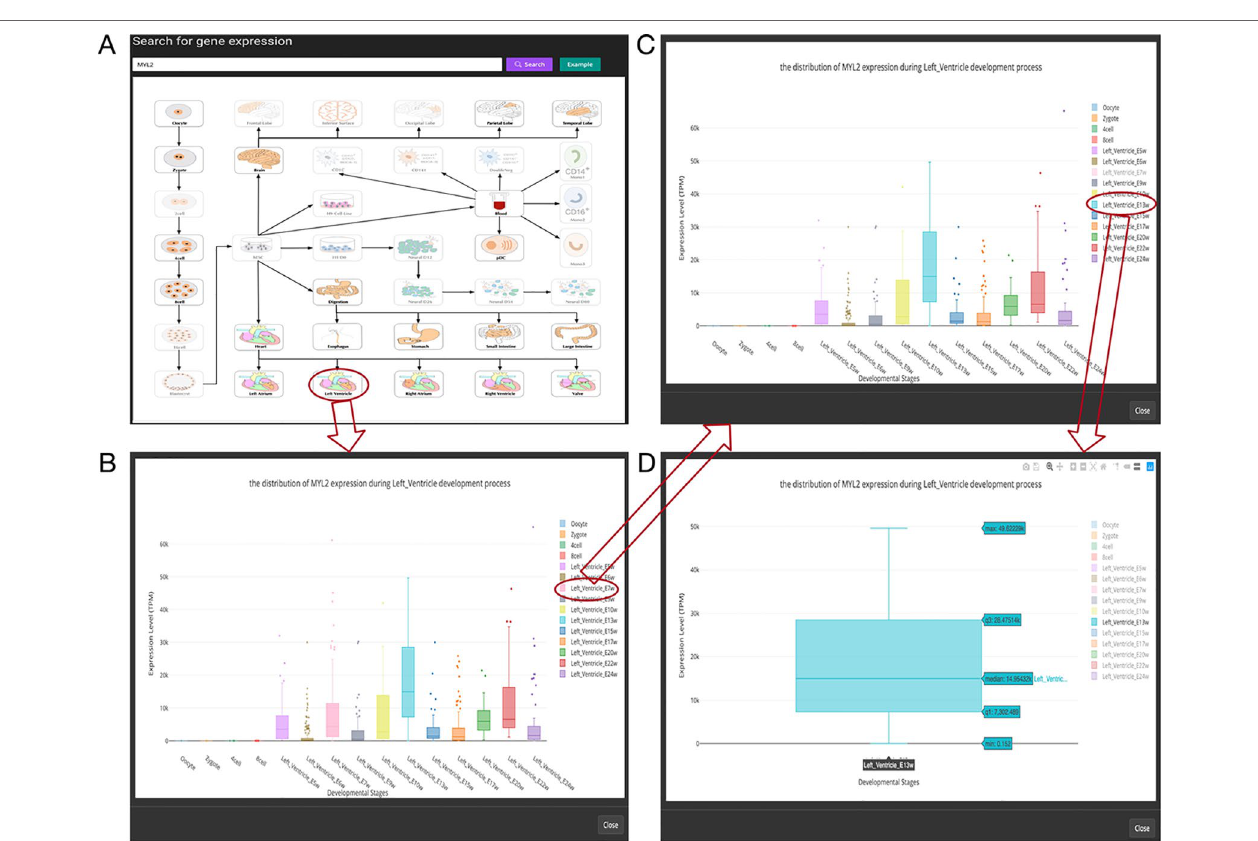
FIGURE 3 | Overview of the gene expression search page. (A) Searching result of the gene “MYL2”. (B) Boxplot shows expression level distribution of MYL2 during developmental process by clicking the image. (C) The function of removing uninterested developmental stages by clicking the name of the stage listed in the figure legend. (D) An example of double clicking on a stage